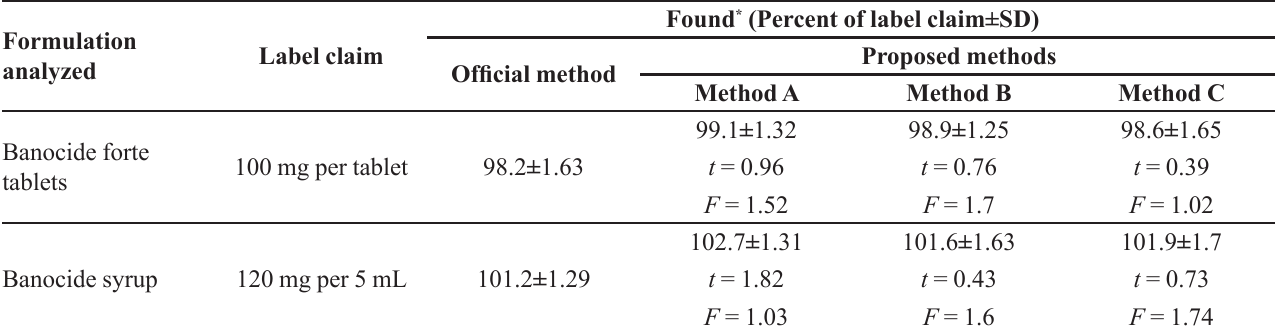
TABLE III - Results of analysis of formulations by the proposed methods